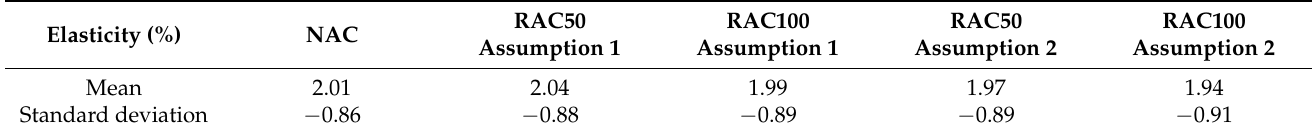
RAC100 Assumption 1